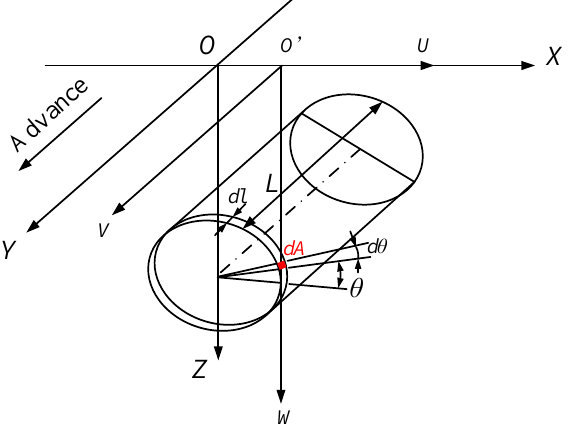
Figure 10. Ground movements caused by f d : ( a ) Settlement; ( b ) Horizontal displacement.